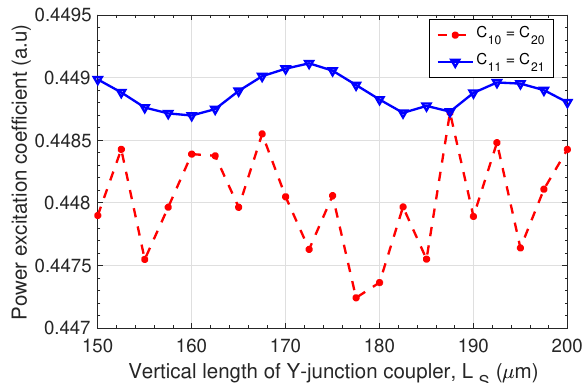
Figure 3. Power excitation coefficients of the TE modes as functions of the length L of the Y-junction S